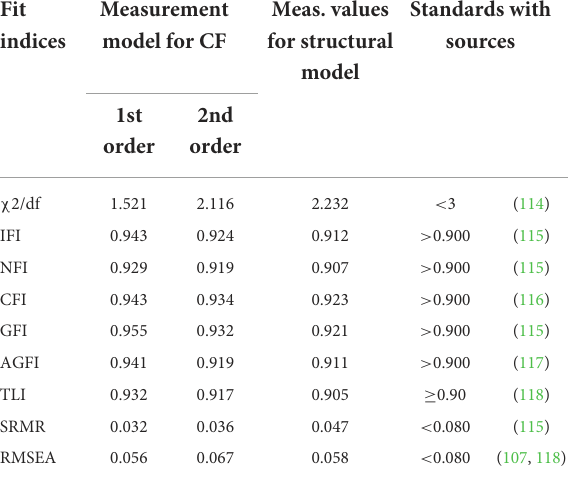
TABLE 4 Results of CFA and structural model with